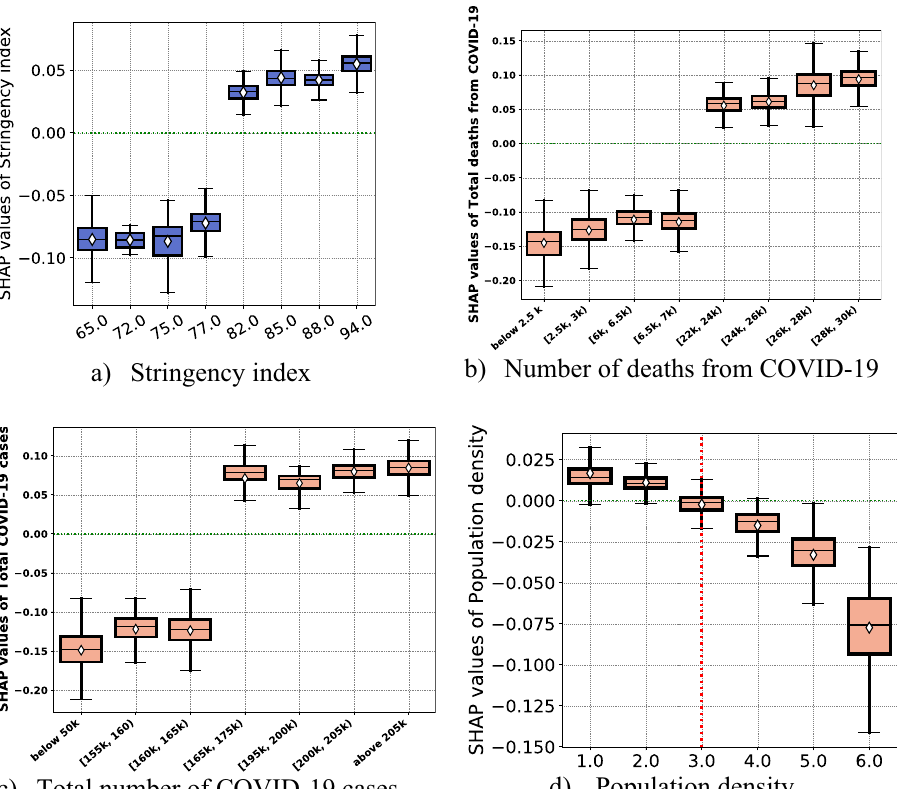
Figure 2. Partial effects of stringency policy response and local infection rate. Notes : This figure displays SHAP dependence boxplots of the stringency index. The diamond symbol in the boxes denotes the average of the SHAP value distribution per each value of the stringency index during the first wave of the pandemic. In panel ( d ), the labels in the x-axis correspond to the number of people in the respondent’s residential area, (1) “isolated dwelling”, (2) “less than 2000”, (3) “between 10,000 and 2000”, (4) “between 50,000 and 10,000”, (5) “between 100,000 and 50,000”, and (6) “more than 100,000”. The values in the x-axis of panels ( b ) and ( c ) are the number of deaths and cases summarized in a few